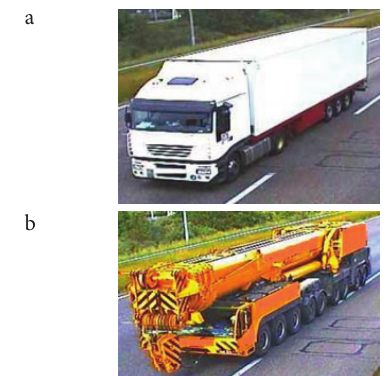
Fig. 1. Examples of recorded vehicles: a ‒ 5-axle truck; b ‒ large (mobile) crane